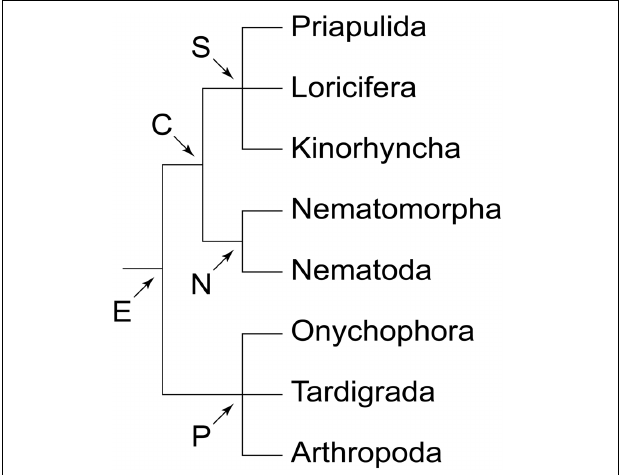
FIGURE 1 | Phylogeny of Ecdysozoa (molting animals). Trichotomies indicate unresolved relationships. Phylogenetic relationships combined after Mayer and Whitington (2009b) and Nielsen (2012). Abbreviations: C, Cycloneuralia; E, Ecdysozoa; N, Nematoida; P, Panarthropoda; S, Scalidophora.